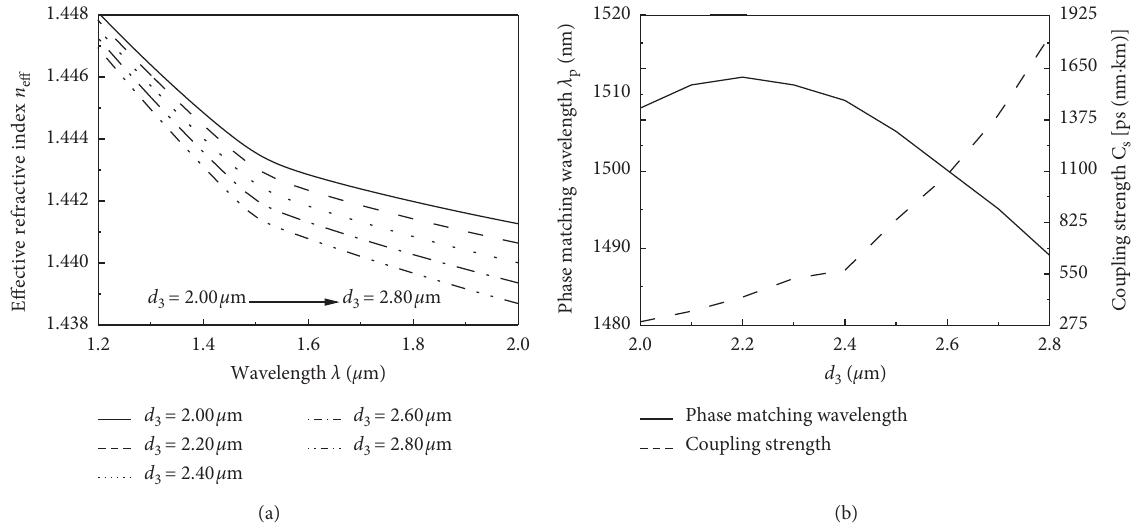
Figure 6: Variation of the effective refractive index of the fundamental supermodel with wavelength when d coupling strength with d 3